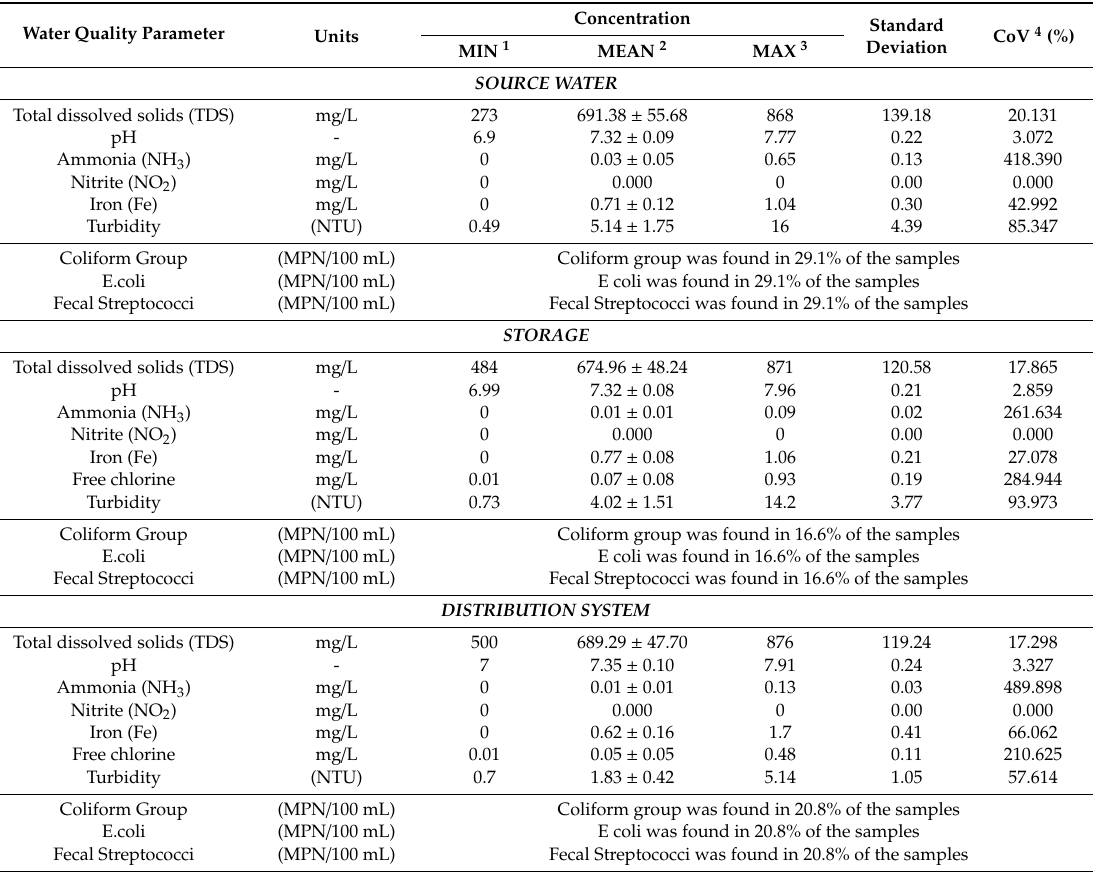
Table 5. Summary of water quality monitoring results for Water Supply System-II during the assessment period between 2016 and